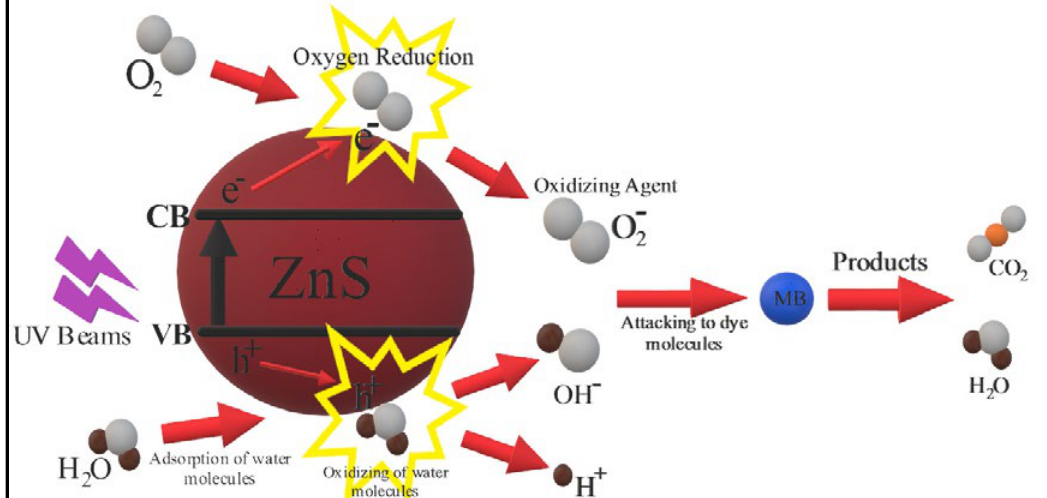
Figure 10 . Schematic illustration of redox reactions occuring on the surface of ZnS nanoparticles Fig. 10. Schematic illustration of redox reactions happening on the surface of ZnS nanoparticles under UV under UV irradiation.